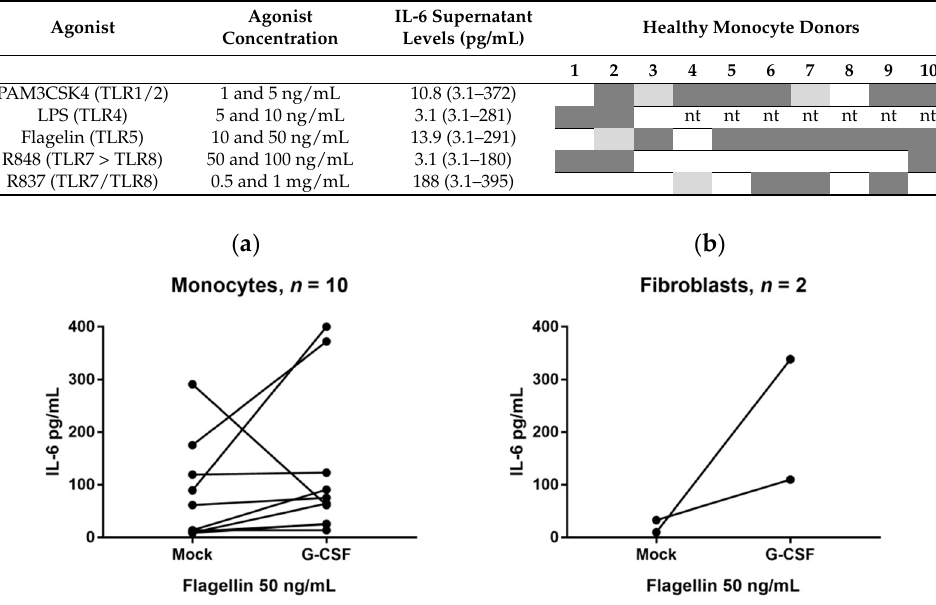
Figure 3. IL-6 release by monocytes derived from 10 healthy individuals ( a ). The cells were cultured with and without exogenous G-CSF 50 ng/mL in the presence of the TLR agonists Flagellin (TLR5) 50 ng/mL. The results are presented as the IL-6 levels in culture supernatants; ( b ) IL-6 release by HFL1 and Hs27 fibroblasts cultured with and without exogenous G-CSF 50 ng/mL in the presence of Flagellin (TLR5) 50 ng/mL; the results from a typical experiment are presented. The results are presented as the IL-6 levels in culture supernatants; the effect of G-CSF on IL-6 release by fibroblasts was detected in six independent experiments.